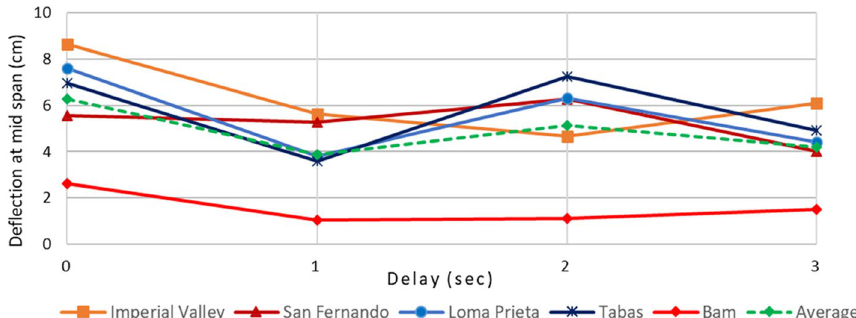
Fig. 18 Maximum deflection at mid span